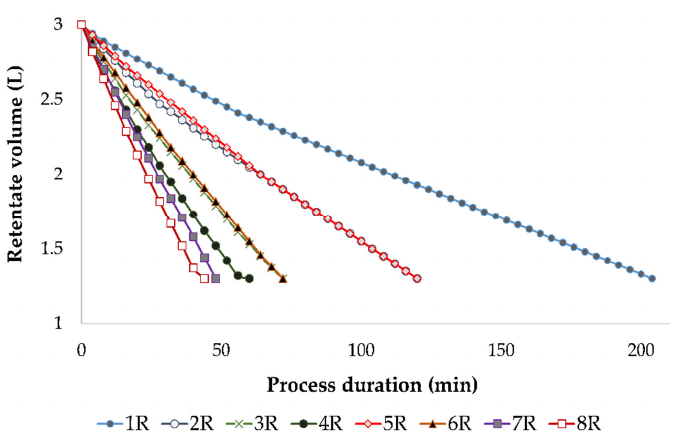
Figure 2. Reduction of the retentate volume (L) during the concentration of the conventional and ecological Cabernet Sauvignon red wines by reverse osmosis at 2.5, 3.5, 4.5 and 5.5 MPa, with and without cooling. Abbreviations: R—reverse osmosis process; 1—2.5 MPa, with cooling; 2—3.5 MPa, with cooling; 3—4.5 MPa, with cooling; 4—5.5 MPa, with cooling; 5—2.5 MPa, without cooling; 6— 3.5 MPa, without cooling; 7—4.5 MPa, without cooling; 8—5.5 MPa, without cooling.